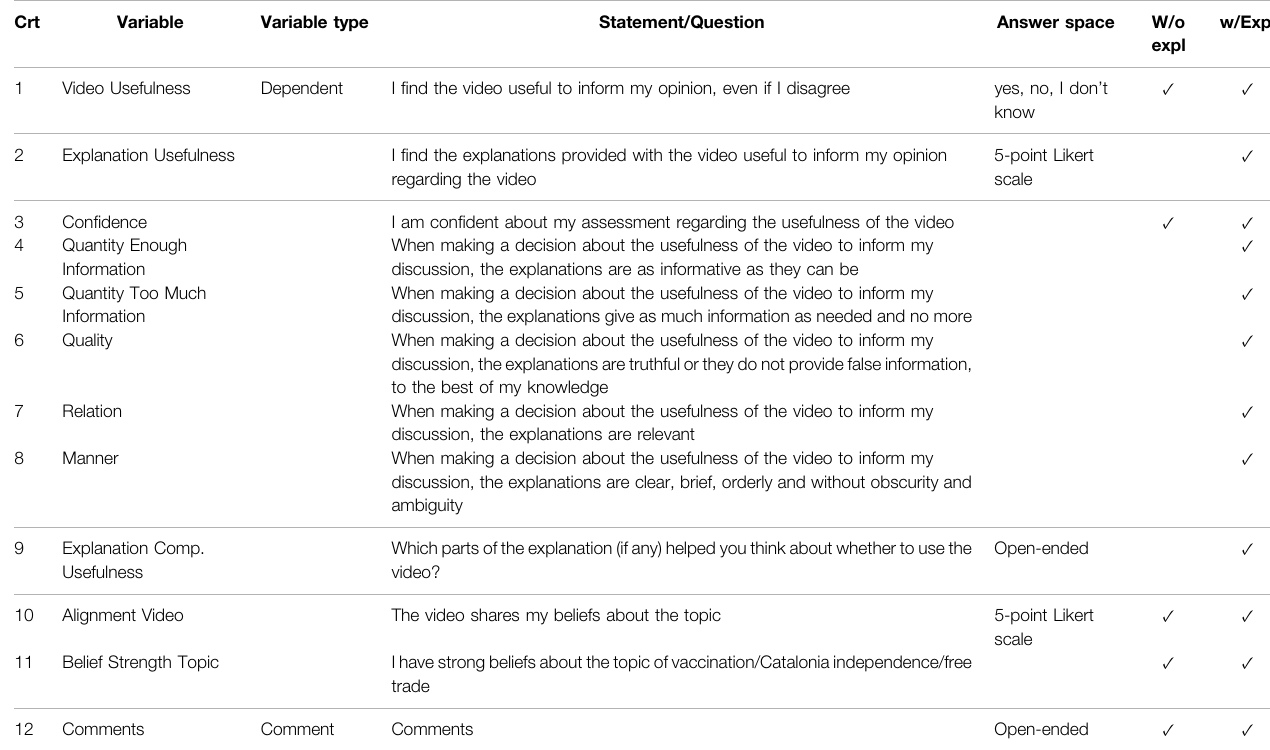
TABLE 3 | Statements and questions included in the between-subjects user